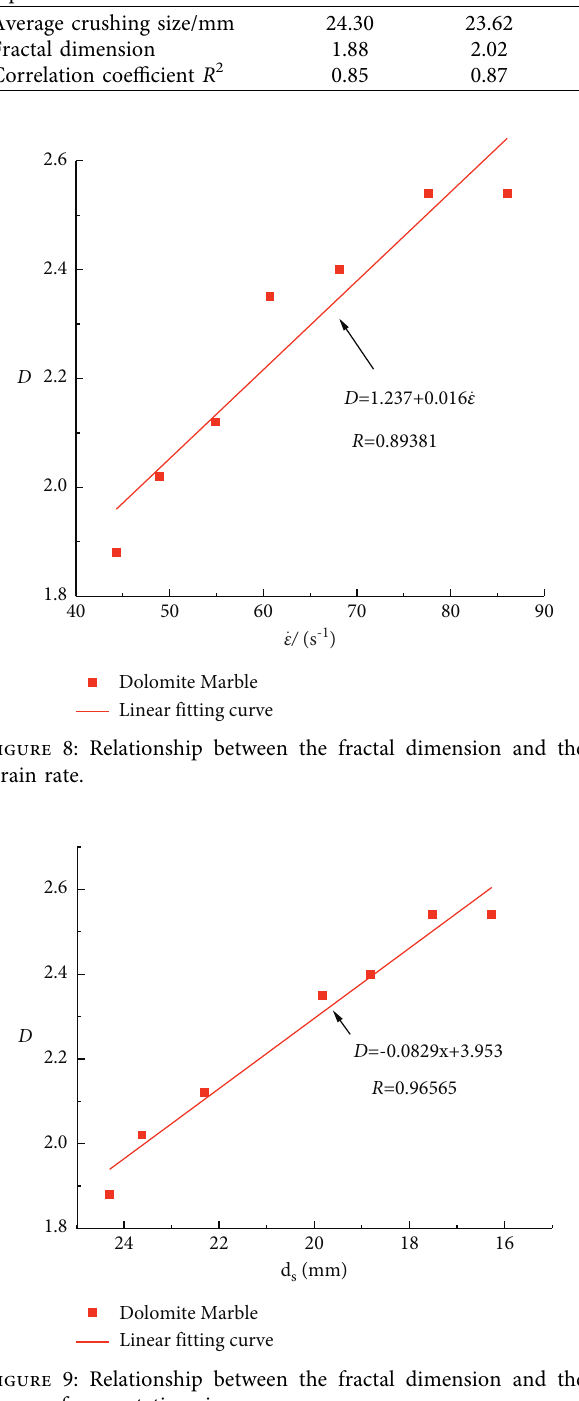
Table 4: Fragmentation statistics of dolomite marble under impact loading. Specimen no.